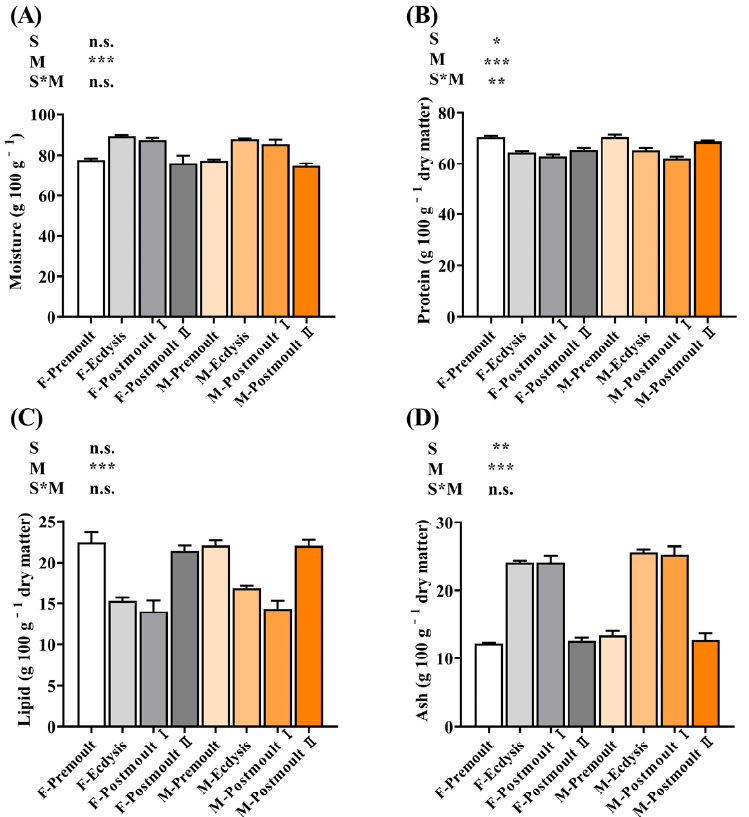
Figure 2. Effects of sex and moult stages on the proximate composition (g 100 g − 1 dry weight) of the edible part of mud crab. ( A ) moisture; ( B ) protein; ( C ) lipid; ( D ) ash. Columns represent means with bars indicating the standard error (n = 3). Two-way ANOVA p -values are shown in each panel, with “S” representing the effects of sex, “M” representing the effects of moulting stages, and “S*M” representing the interaction between sex and moulting stages. n.s., not significant ( p ≥ 0.05). The differences were considered statistically significant at values of * p < 0.05, ** p < 0.01, and *** p < 0.001.